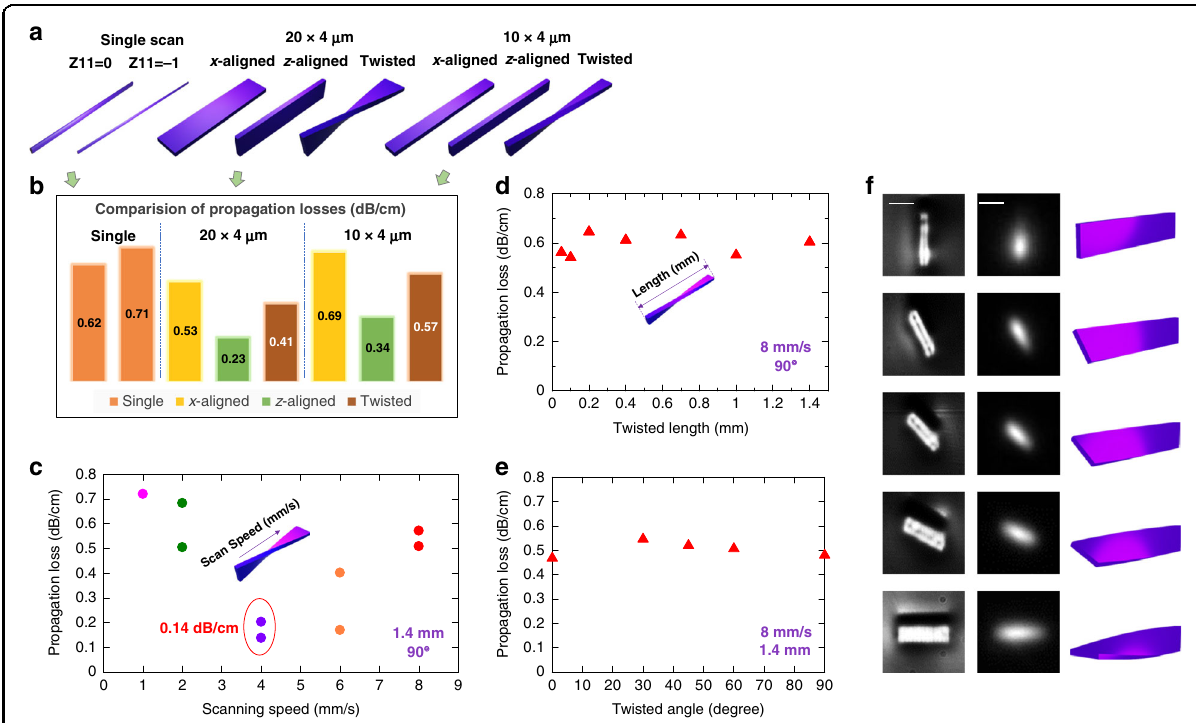
Fig. 3 Light-guiding performance of SPIM-WGs. All images (LED, laser) have the same frame size of 30 × 30 µm. Scale bars are 10 µm. a Sets of waveguides were fabricated with different cross-section shapes and sizes. Classic single-scan, x- aligned, z- aligned waveguides were two waveguides per set, while twisted waveguides (twisted length of 1.4 mm) were four (two z- aligned input facet, two x- aligned input facet) per set. Cross-section images are included in Supplementary Fig. S3. b Comparison of propagation losses for classic single-scan, x- aligned, z- aligned and twisted waveguides. Each number presented in the fi gure is an average of two measured waveguides for single-scan, x- aligned, and z- aligned sets; an average of four waveguides for twisted sets. The fabrication speed was 8 mm/s. c Twisted waveguides ’ propagation losses versus laser focal spot scanning speed. The cross-section size was 20 × 4 µm, twisted length was 1.4 mm, twisted angle was 90°. d Twisted waveguides propagation losses versus twisted region length. Cross-section size was 10 × 4 µm, laser scanning speed was 8 mm/s (sacri fi cing loss to gain fabrication ef fi ciency), twisted angle was 90°. e Twisted waveguide propagation losses versus twisted angle. Cross-section size was 20 × 4 µm, laser scanning speed was 8 mm/s (sacri fi cing loss to reduce fabrication time), twisted length was 1.4 mm. f Demonstration of beam rotation by several sets of twisted waveguides with varying twisted angle. Left: LED transmission microscopic images of waveguide facet. Middle: measured 1550 nm laser-mode pro fi le images. Right: diagrams of twisted SPIM-WGs with different